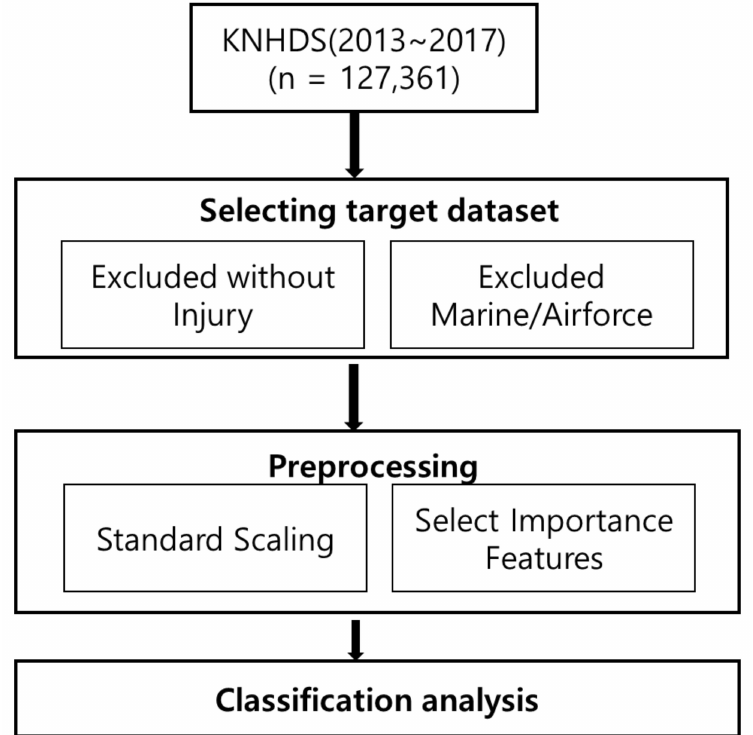
Figure 1. Sample data processing